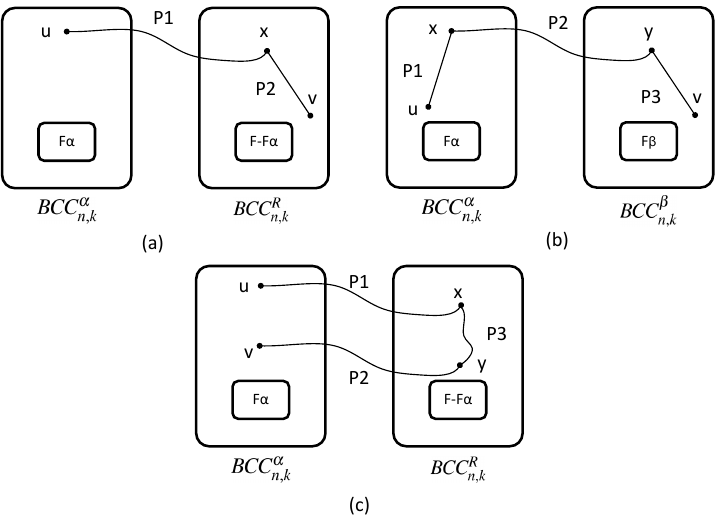
Figure 5. Figure ( a ) is subcase 1.1.1.1; Figure ( b ) is subcase 1.2; Figure ( c ) is subcase 2.